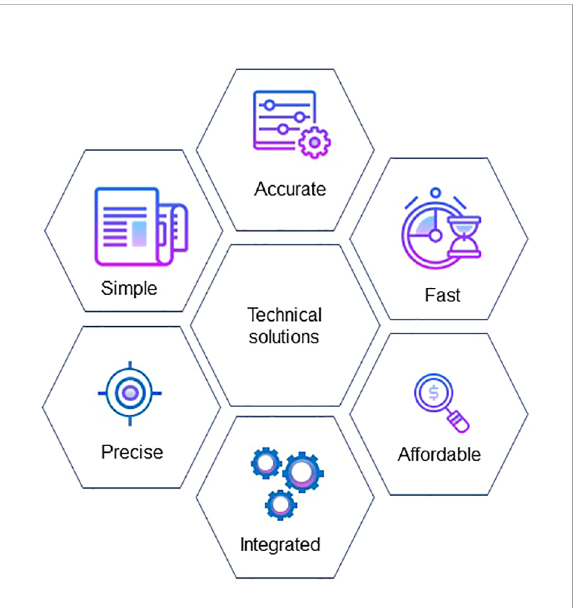
FIGURE 3 Minimum requirements for maximum adoption of technical solutions by the viticulture